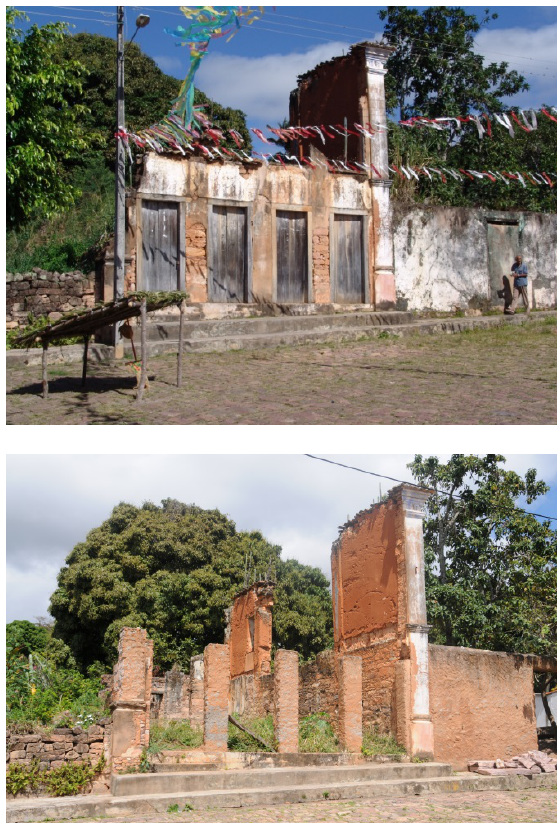
Figure 1. Example of house destruction during the period (2005-2010) at Igatú, in Chapada Diamantina.